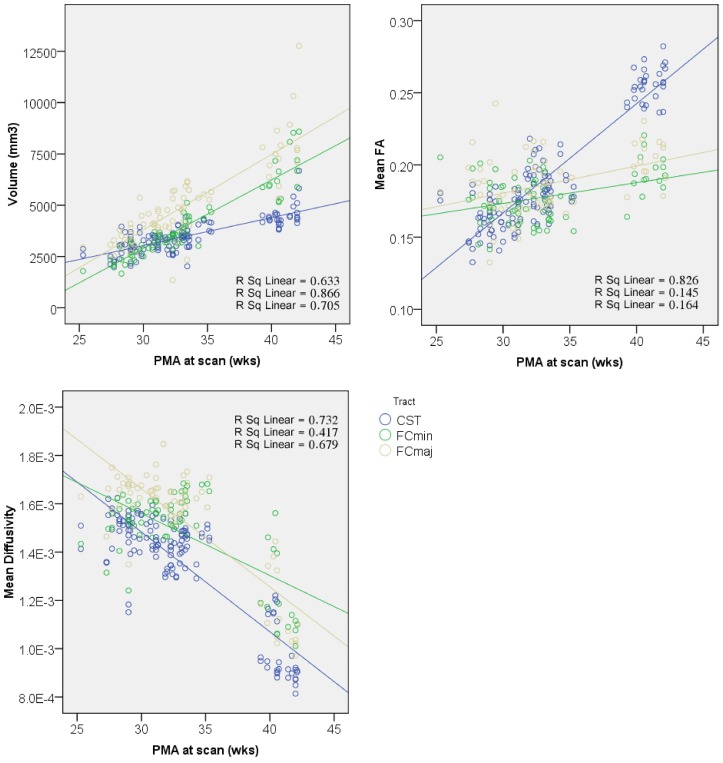
Differences in rate of white matter maturation during preterm period shown in corticospinal (CST, blue) and forceps minor (FCmin, green) and forceps major (FCmaj, yellow).CSTs displayed faster rate of change of FA and MD, possibly due to an earlier onset of myelination [39], whereas callosal fibers exhibited faster volumetric growth. PMA; post-menstrual age, FA; fractional anisotropy, MD; mean diffusivity.